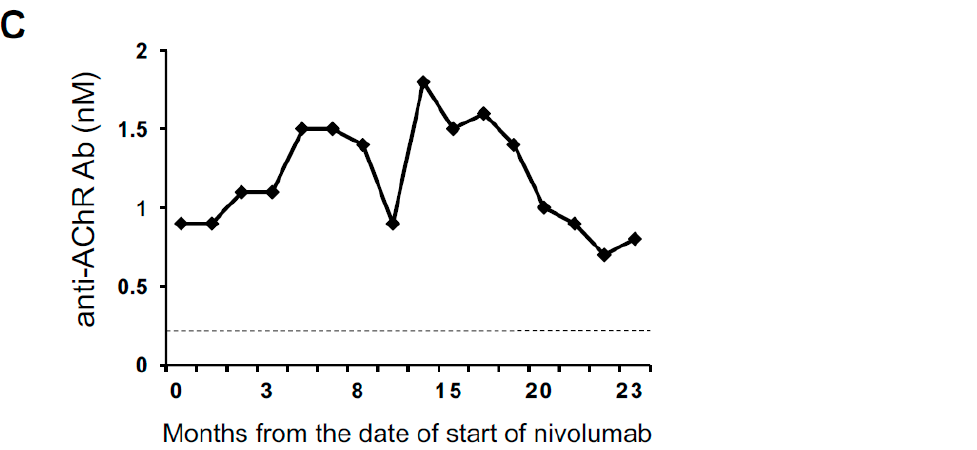
Figure 1. Key imaging and longitudinal analysis of the levels of anti-AChR Abs in asymptomatic anti-AChR Ab-seropositive patient who had a complete response to an anti-PD-1 antibody therapy. Panel ( A ) and ( B ) show FDG-PET/CT imaging pre-nivolumab and post-nivolumab. Arrows in panel ( B ) indicate supraclavicular lymph node (upper panels) and mediastinal lymph node (lower panels) metastases. Panel ( C ) shows the longitudinal analysis of serum concentrations of anti-AChR Ab (nM) before and after nivolumab. The dashed line indicates a normal upper limit of the concentrations of anti-AChR Abs.